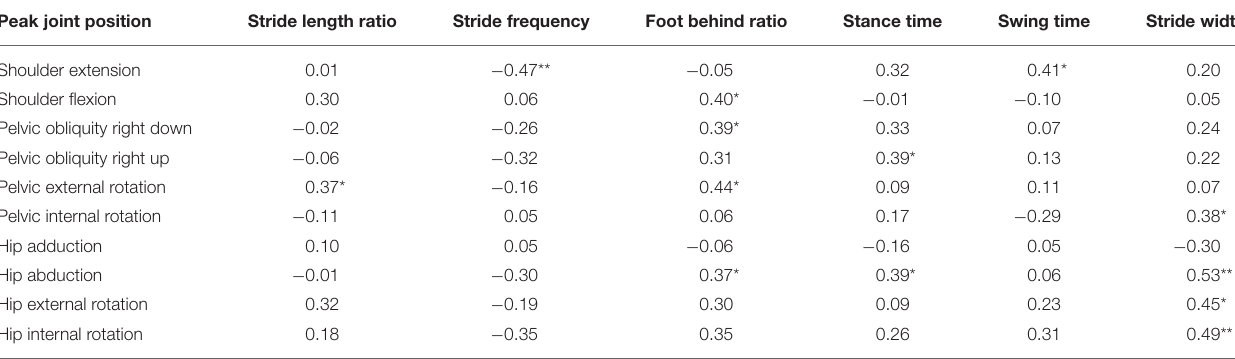
TABLE 3 | Relationships ( r ) between spatiotemporal variables and upper body minimum and maximum joint angles. Peak joint position